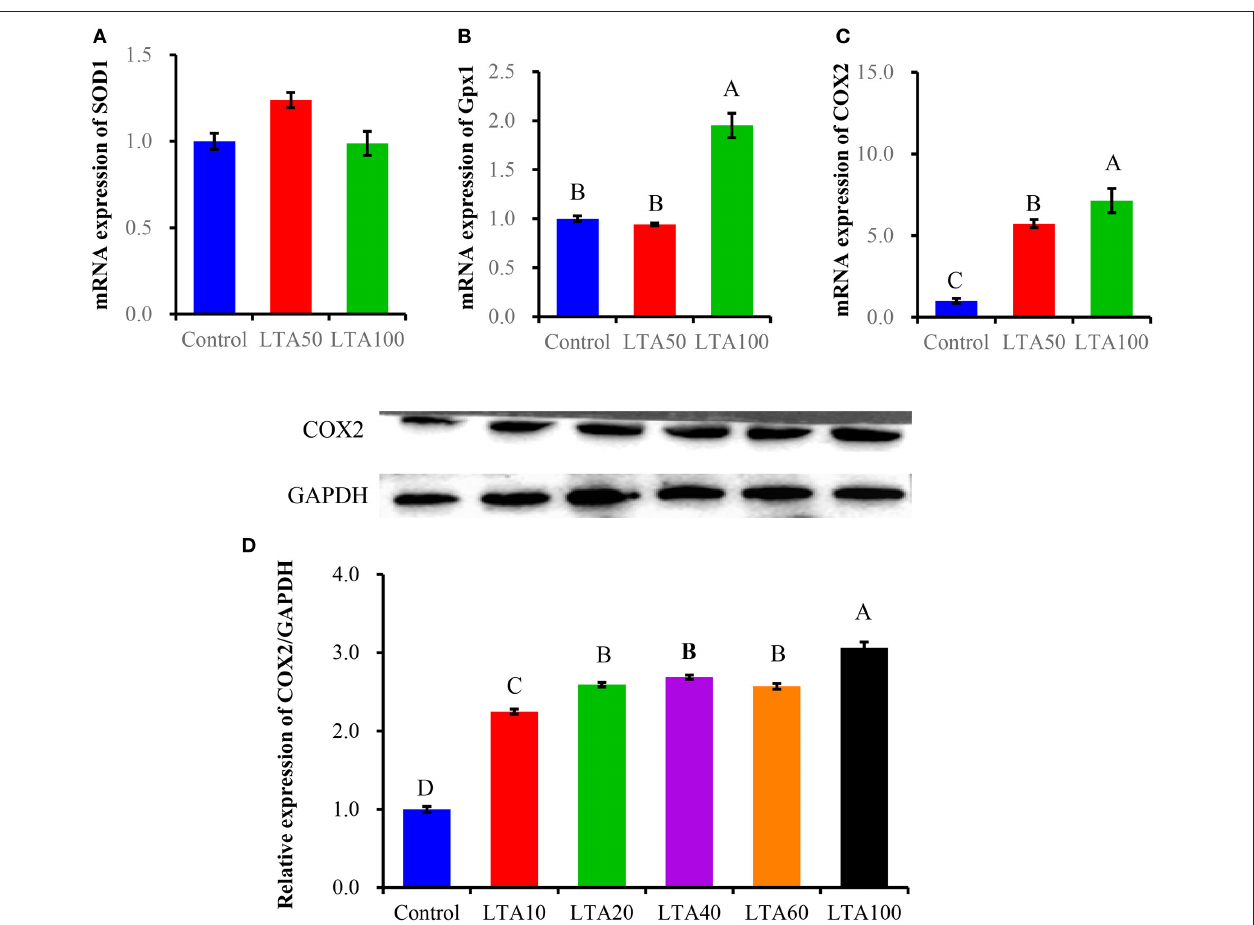
FIGURE 2 | Dose-dependent effect of LTA in PBMECs. Effect of lipoteichoic acid on SOD1 and Gpx1 antioxidant enzyme and COX2 expressions measured in PBMECs to determine the suitable LTA dose by qRT-PCR (A–C) . For optimum LTA dose confirmation, the expression of COX2 protein was measured in PBMECs stimulated with LTA (100 µ g/mL) (D) . Glyceraldehyde-3 phosphate dehydrogenase (GAPDH) is used as a control. Graphs show the densitometric analysis (protein/GAPDH) from three independent experiments. Values represent means ± SEM. LTA, lipoteichoic acid. Different uppercase letters (A–D) on the top of bars indicate significant differences ( n = 3, p < 0.05) among the groups. TABLE 1 | Sequence of primers used in this study. Genes Sequence (5 ′ -3 ′